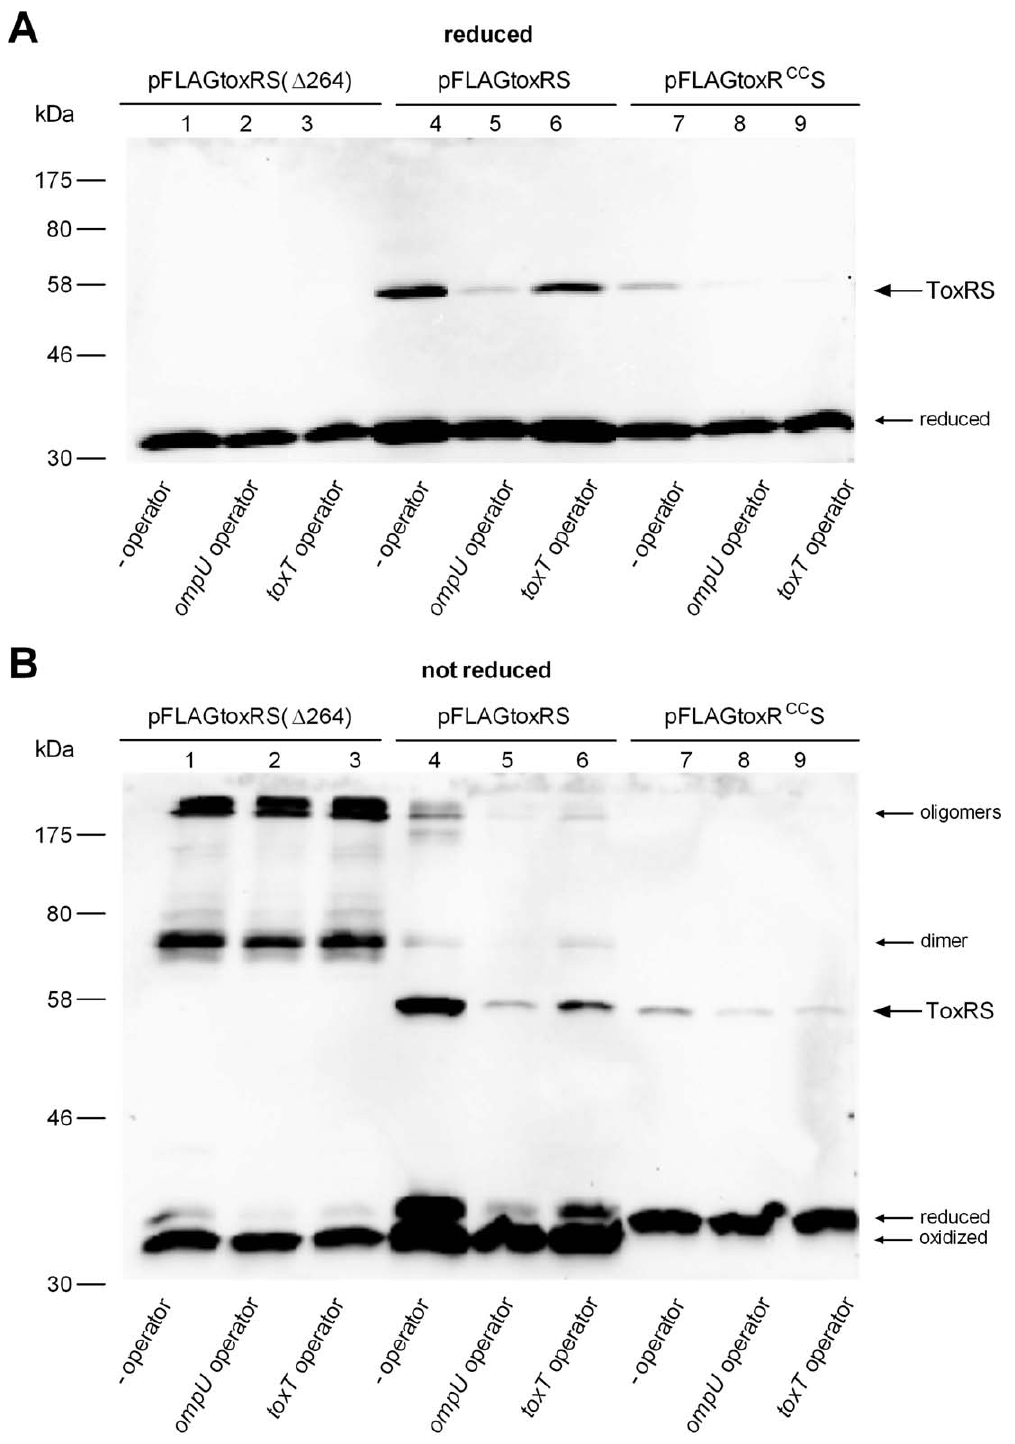
Figure 6. toxRS coexpression in E.coli XL1-Blue strain. Shown are immunoblot analyses utilizing anti-FLAG antibodies to monitor FLAG-tagged ToxR production of pFLAGtoxRS constructs, performed under reducing (panel A) and non-reducing conditions (panel B). pFLAGtoxRS was expressed in E. coli cells grown in LB broth to mid-log phase (OD 600 of 0.5) and subsequently induced with IPTG for 1 h. From left to right, shown are pFLAGtoxRS( D 264), pFLAGtoxRS and pFLAGtoxR CC S, either containing no ToxR operator sequence or ompU or toxT operator sequences, respectively. A 55 kDa ToxR cross-reacting protein band, associated with pFLAGtoxRS and pFLAGtoxR CC S, is indicated by an arrow. To note, cysteinyl dependent homodimer and oligomer ToxR bands occurred diminished as observed for pFLAGtoxRS in comparison to pFLAGtoxRS( D 264). Molecular size markers are indicated on the left. Immunoblot analysis was performed at least three times, and results were reproducible.